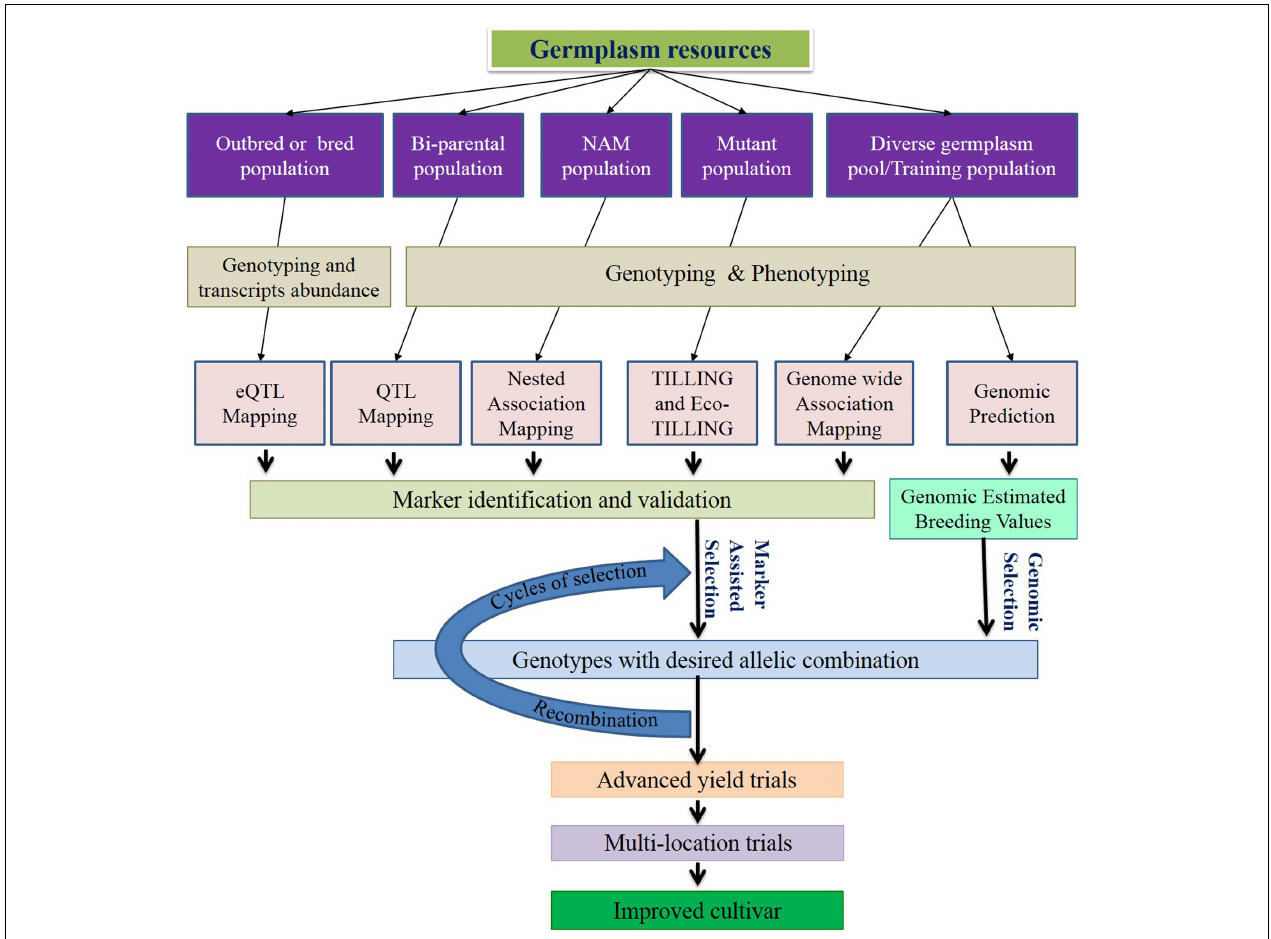
FIGURE 1 | Schematic diagram of genomics-assisted breeding. Genomics technologies help enhancing marker trait association for marker-assisted selection (MAS) and genomic selection (GS). Both MAS and GS speedup selection cycles, increases precision and improves genetic gain per year. Selection and recombination will be repeated multiple times before the yield trials to increase the favorable allele frequency. Incorporation of genomics to the recurrent selection strategies substantiates the effectiveness of breeding